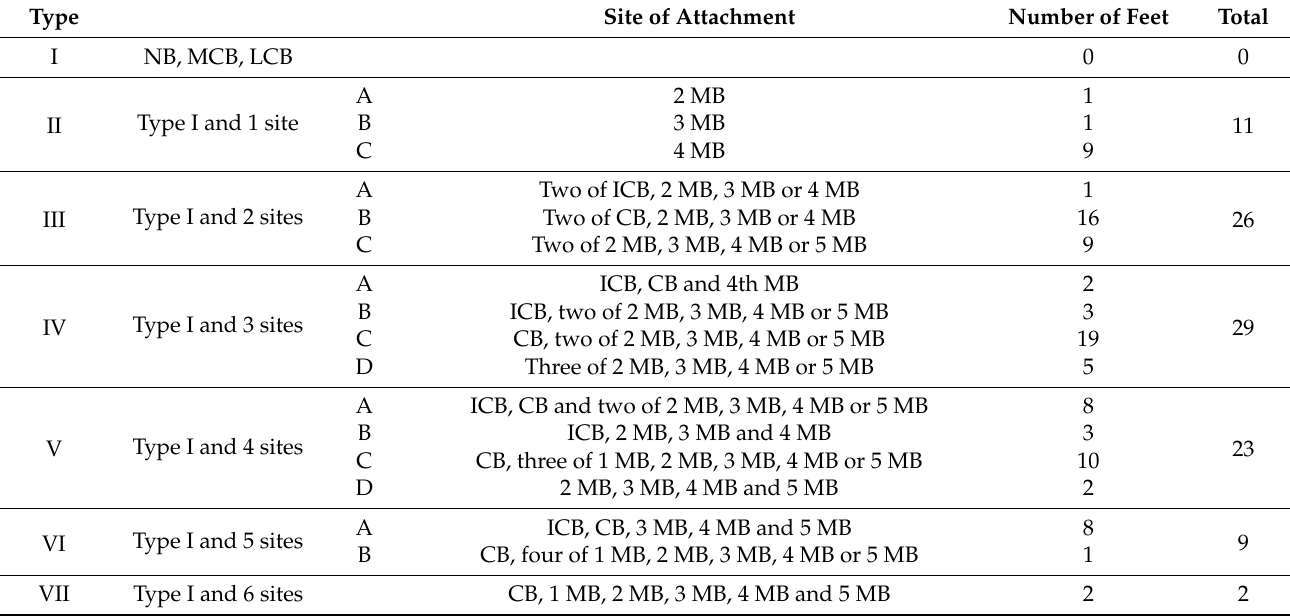
Table 2. Type classification for site of tibialis posterior tendon